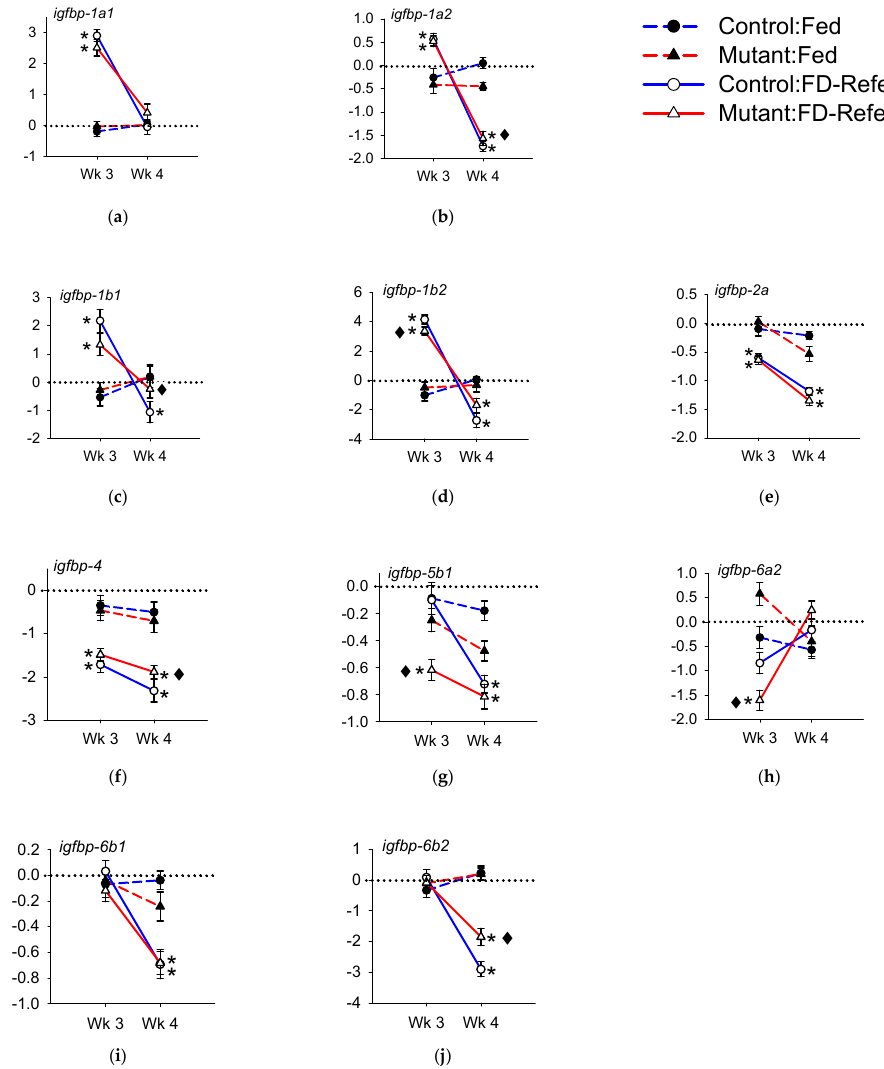
Figure 6. Hepatic expression of igfbp genes during feed deprivation (FD) and refeeding in controls (blue lines) and mutants (red lines). Genes are indicated in the top left corner of each panel ( a – j ). The y-axis represents gene expression values normalized to the continuously fed control group from week 3 and expressed as log 2 (fold change). The horizontal dashed line is a visual reference for log 2 (fold change) = 0. Asterisks indicate that the feed-deprived (FD, Wk 3) or refed (Wk 4) groups (solid line) di ff er from continually fed fish (dashed line) within the same treatment group and week ( p < 0.05, n = 21). The black diamond indicates that the fold change di ff ers between mutants and